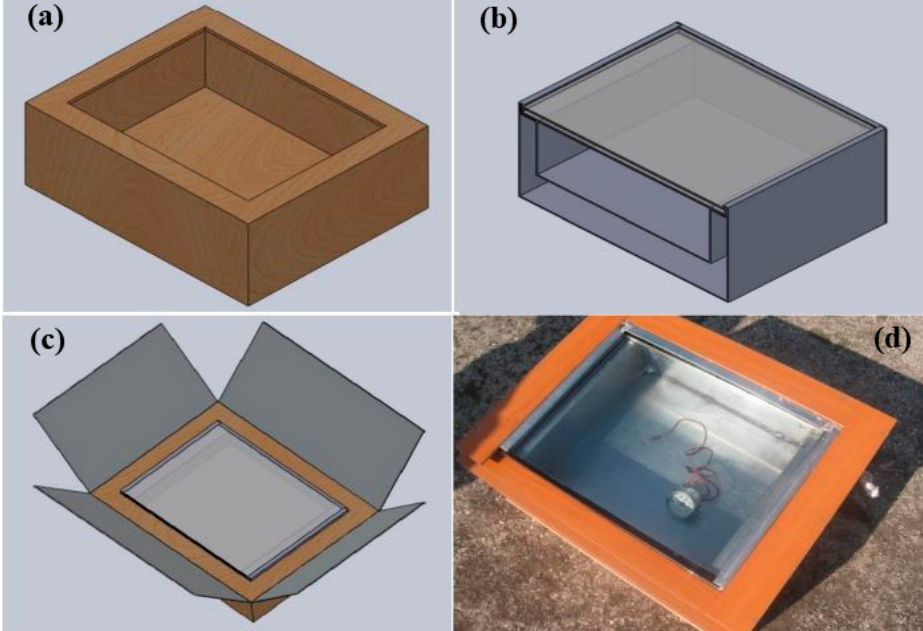
Figure 18. ( a ) Outer box; ( b ) inner box; ( c ) reflectors; ( d ) double-glazed conventional box-type SC. Reprinted/adapted with permission from Ref. [55], 2012, AIP Publishing.